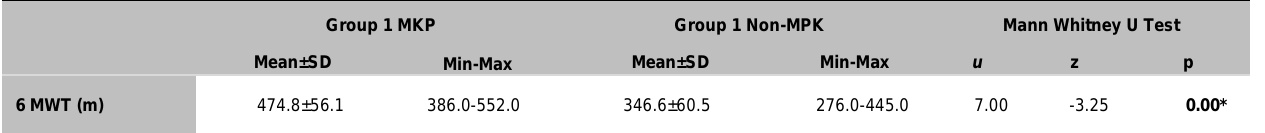
Table 5: Comparison of 6MWT distance of two groups.